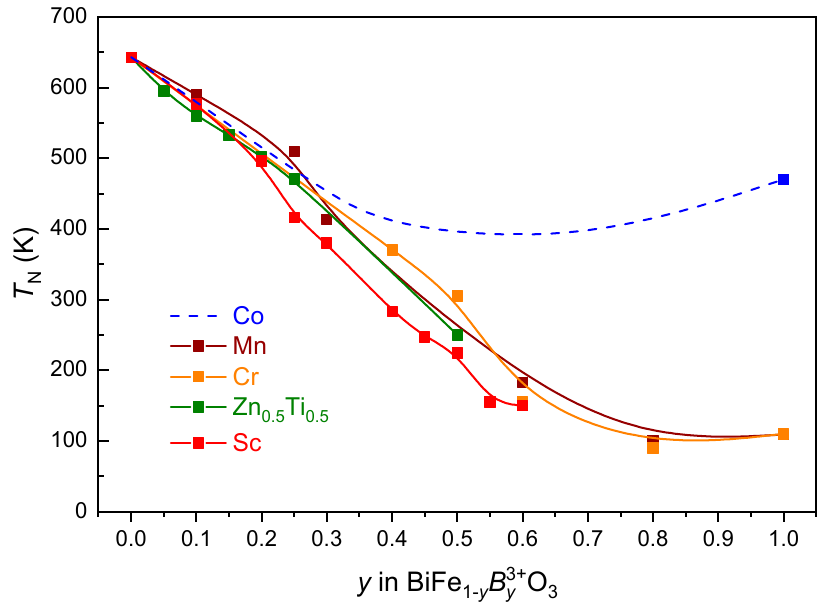
Figure 7. The Néel temperature as a function of y for the BiFe 1 − y B 3+ y O 3 perovskites with B 3+ = Co [39], Mn [12], Cr [29], Sc [26] and Zn 0.5 Ti 0.5 (this work). A suggested T N ( y ) behaviour for the (1 − y )BiFeO 3 – y BiCoO 3 perovskites is shown with the dashed line.